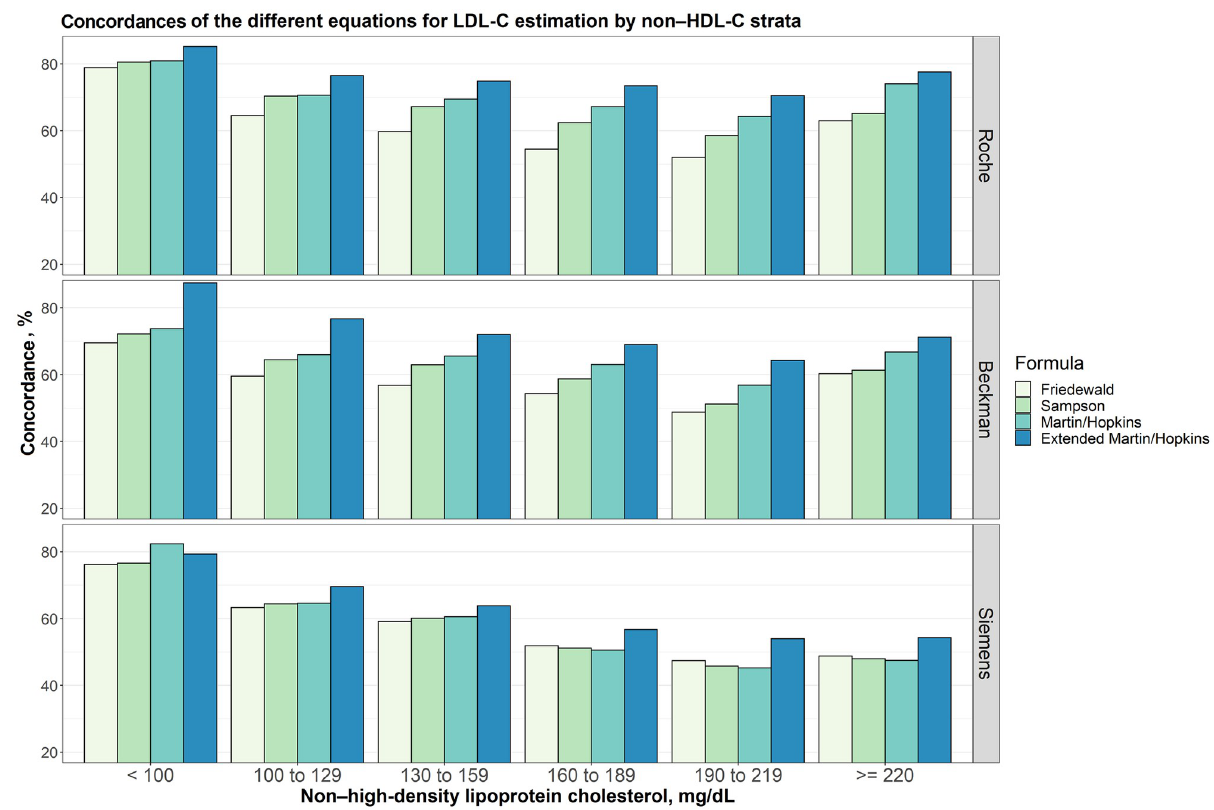
Fig 5. Concordances of the different equations for LDL-C estimation by non-HDL-C strata. Concordances of different equations for LDL-C estimation by non-HDL-C groups assuming different direct measures (i.e., Roche, Beckman and Siemens) are given in a clustered bar chart. Each bar indicates the concordance of estimating LDL-C levels by different formulas for each group of non-HDL-C concentration given that the LDL-C levels measured by Roche, Beckman and Siemens direct methods, accordingly.